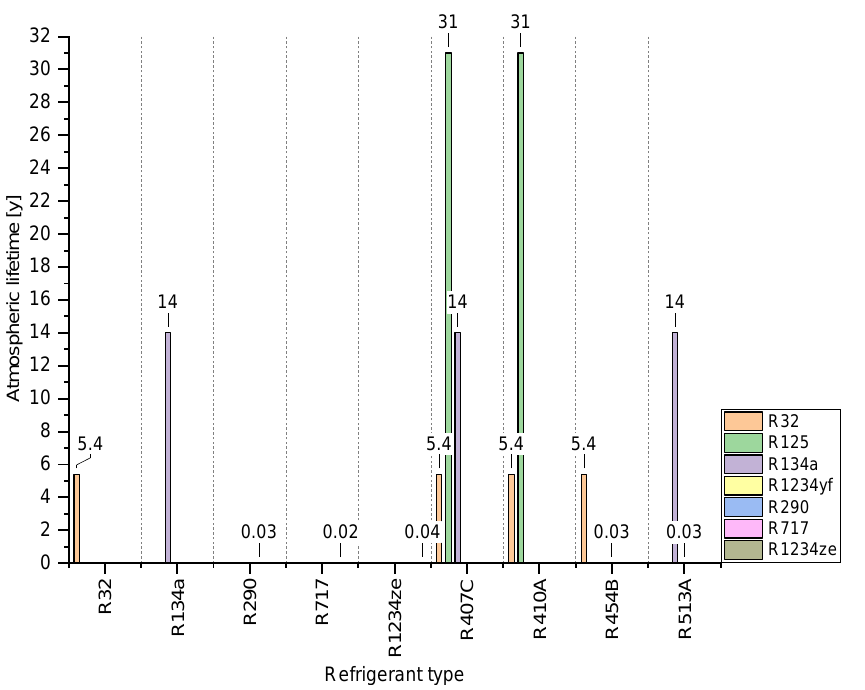
Figure 2. Lifetime in the atmosphere of selected refrigerants [29] .